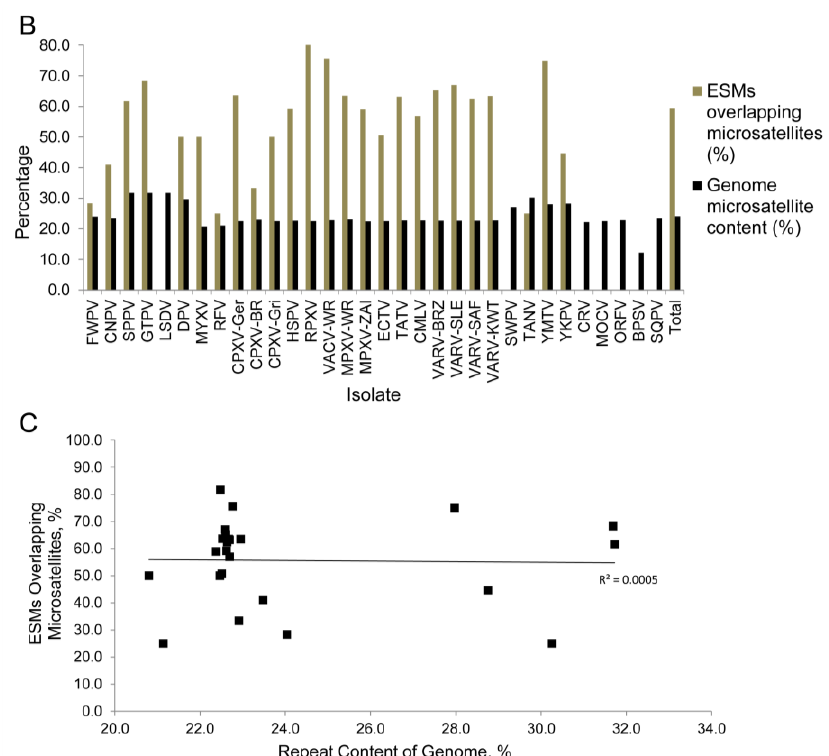
Figure 3. Presence of early stop mutations at microsatellites is independent of repeat content of the genome. ( a ) The number of ESMs which overlap or do not overlap